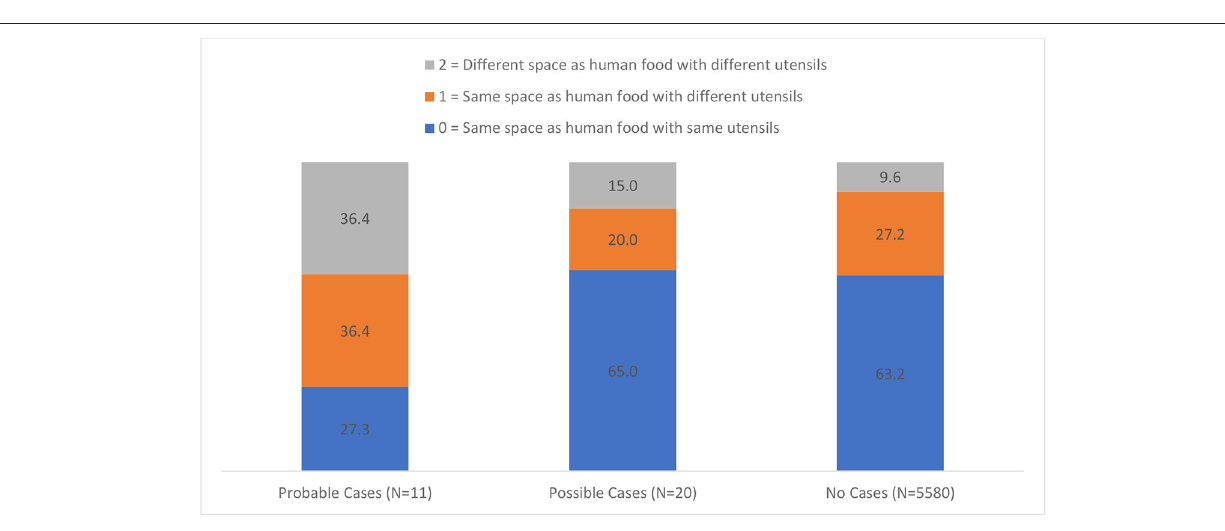
HHs were also categorized into three categories depending